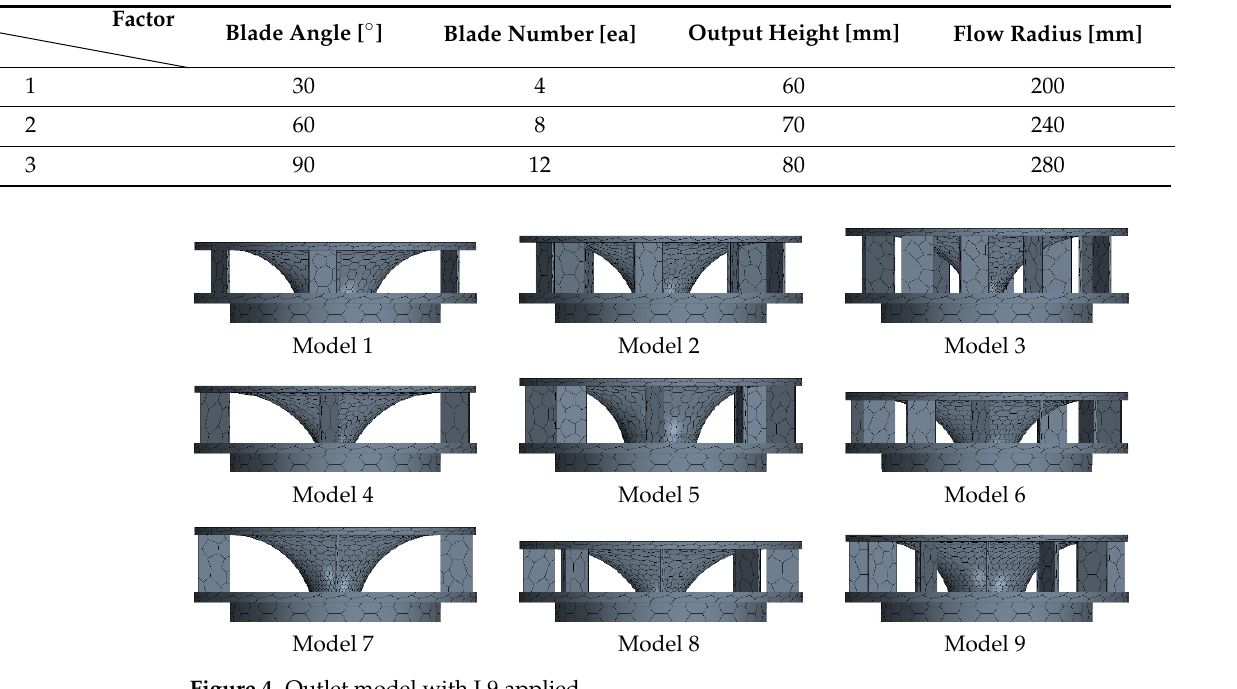
Table 2. Orthogonal array table with design variables